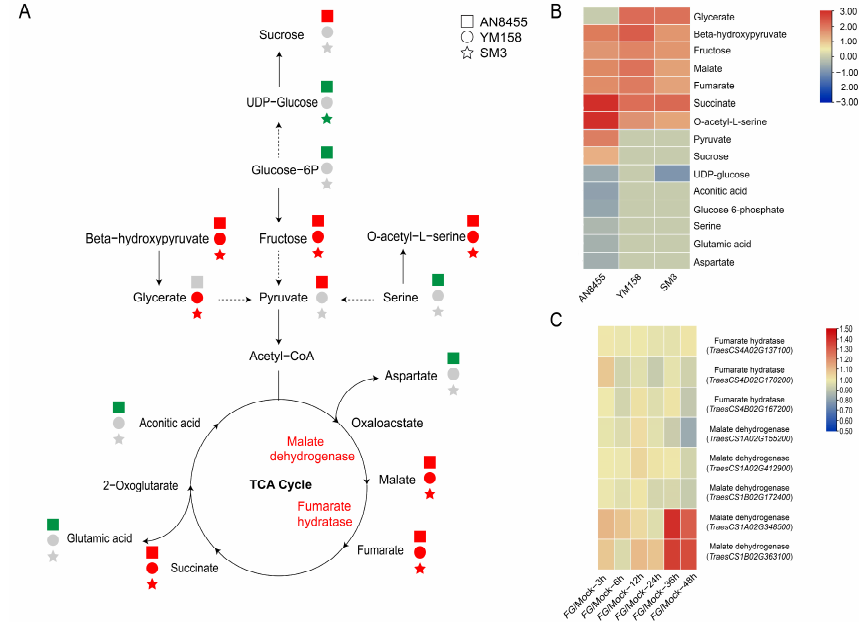
Figure 3. Metabolites that participated in catabolic processes. ( A ) Schematic diagram of catabolic processes. The squares, circles, and stars represent AN8455, YM158, and SM3, respectively. Red, green, and gray shapes represent upregulated expression, no obvious change, and downregulated expression, respectively. ( B ) Radio value ( Fg vs. Mock) of metabolites involved in catabolic processes. ( C ) Gene expression heatmap of enzymes involved in catabolic processes, sourcing from WheatGene (http://wheatgene.agrinome.org/ (accessed on 9 July 2022)).